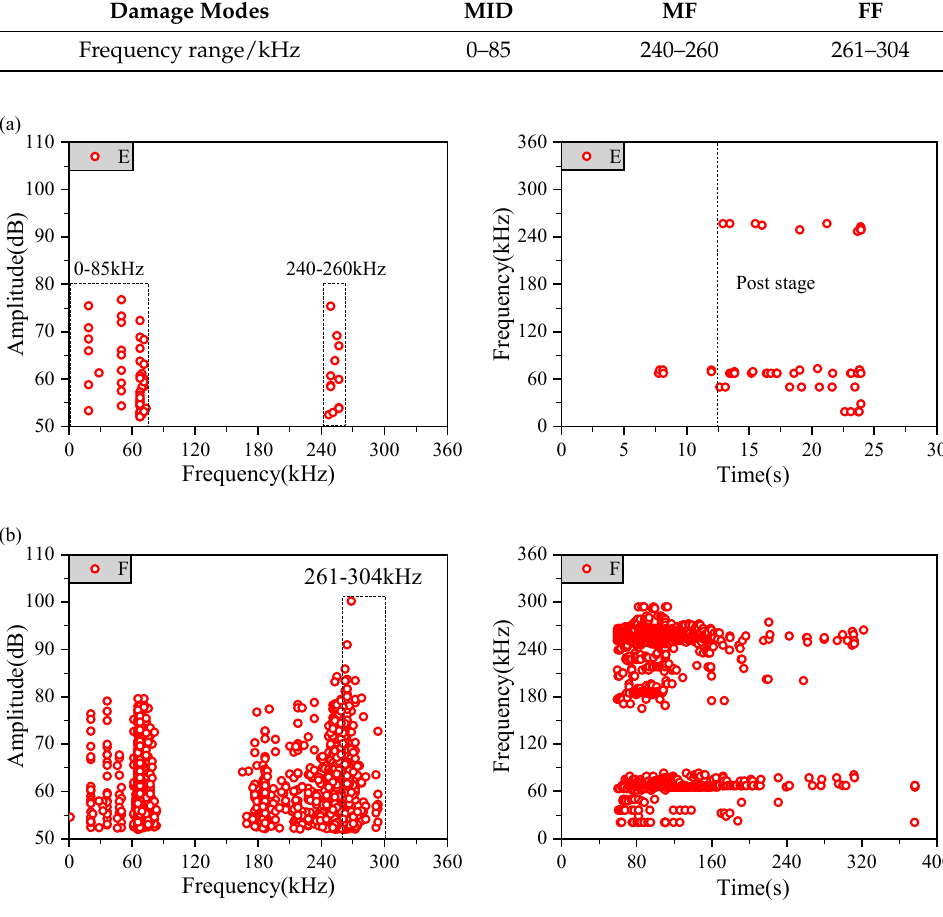
Figure 5. Amplitude–Frequency and Frequency–Time relationship graphs of AE (( a ) Unidirectional laminate [90] 68 , ( b ) Unidirectional laminate [0] 68 ).